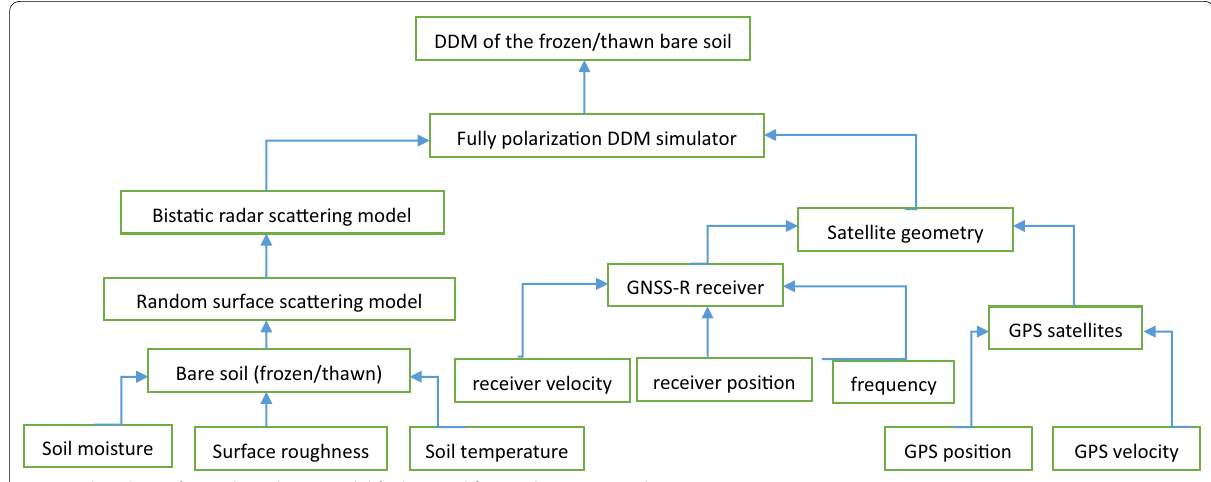
Fig. 1 Flowchart of AIEM-based Z–V model for bare soil freeze/thaw process